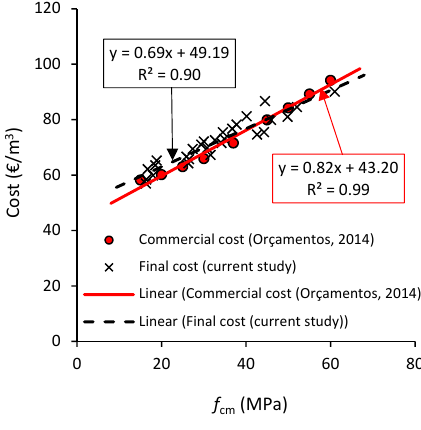
Figure 5. Relationship between compressive strength at 28 days and cost of 1 m 3 of concrete. f cm,cube was converted to f cm according to EN 1992-1-1 [39].